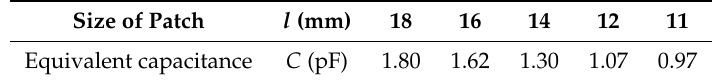
Figure 5. S 21 with different widths of metal patches by full wave simulation when the diode is off. Table 1. Simulation parameters ( h 1 = 0.8 mm, h 2 = 16 mm, w = 1.5 mm, L = 4